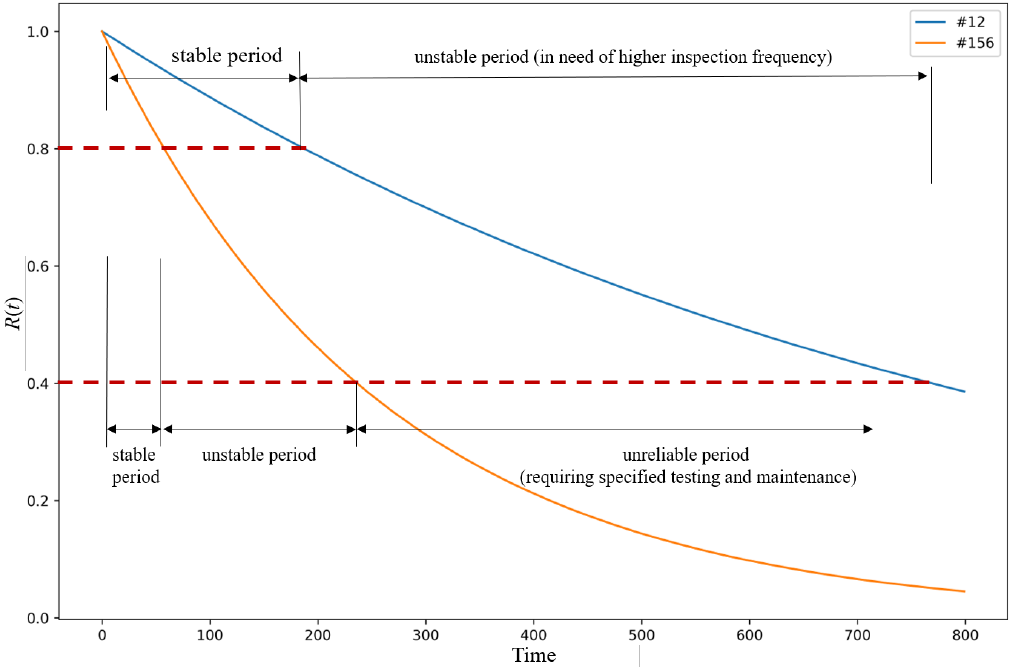
Figure 11. Reliability of deformation joints #12 and #156 changing over time.